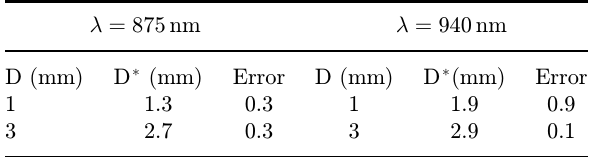
Table 1. The measurement results about arti¯cial vessel (plastic tube) for depth of 3.5 mm.